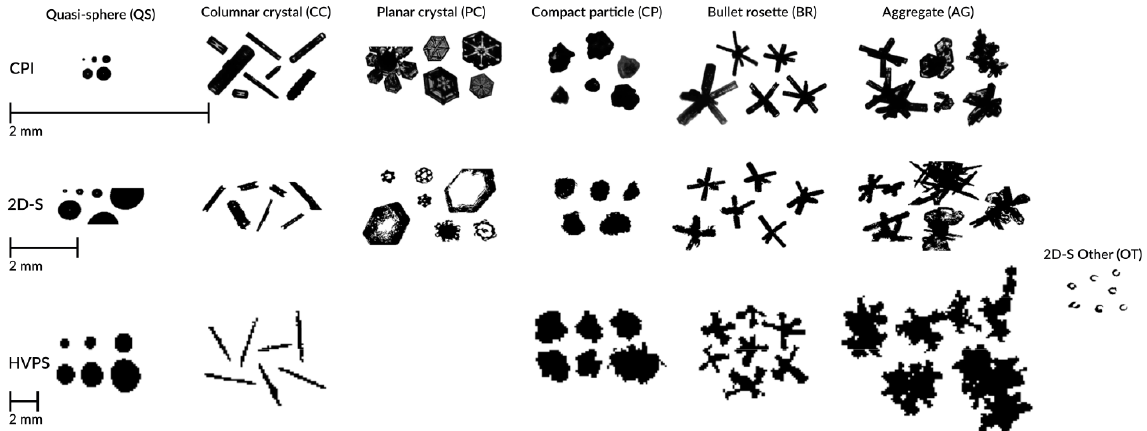
Figure 1. Illustration of ice crystal habits from Praz et al. (2018) for different cloud-imaging